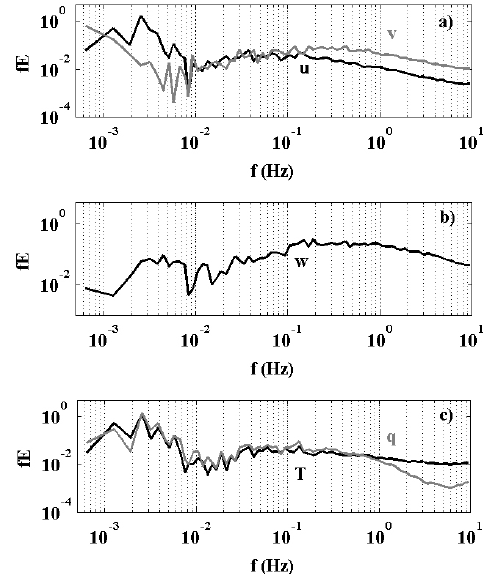
Figure 4. Spectra (in pre-multiplied form) computed for the longitudinal and lateral wind velocity components ( a ), for vertical wind component ( b ) and for temperature and water vapour ( c ) versus the natural frequency ( f ) relative to the time series shown in Figure 2 and sampled at the highest level (10 m).